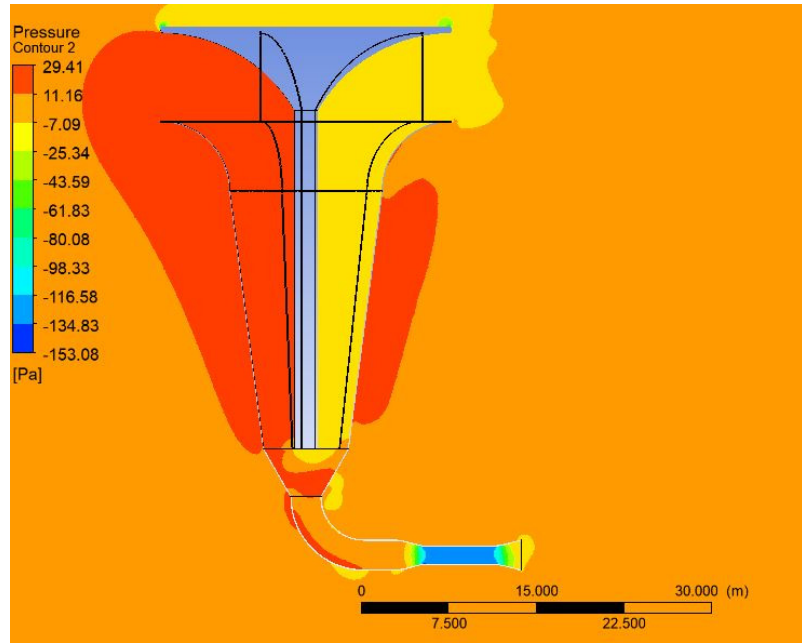
Figure 6. Pressure distribution of the omni-directional wind funnel.